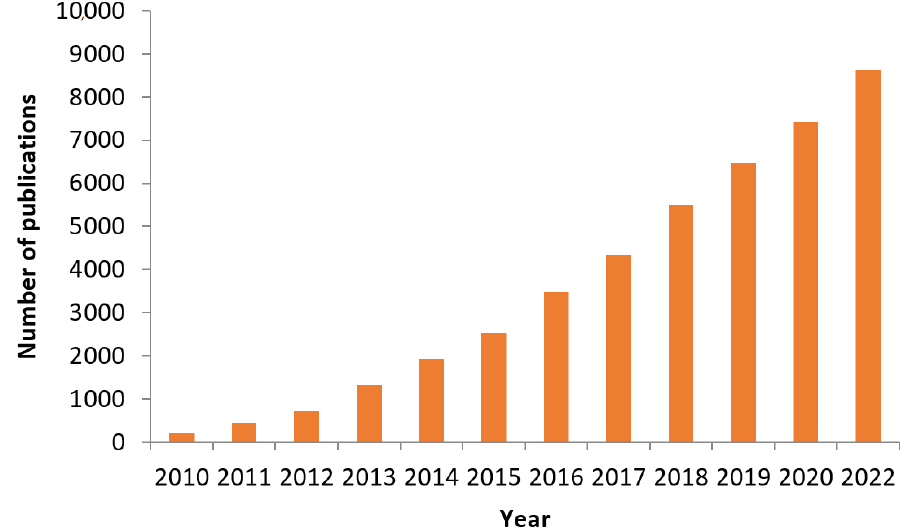
Figure 4. The total numbers of publications using GO in 2010–2021 (ELSEVIER).